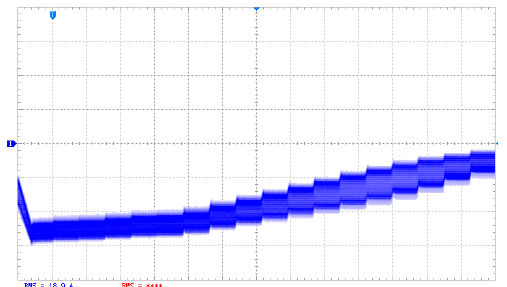
Figure 26. Motor controller bus current when braking.